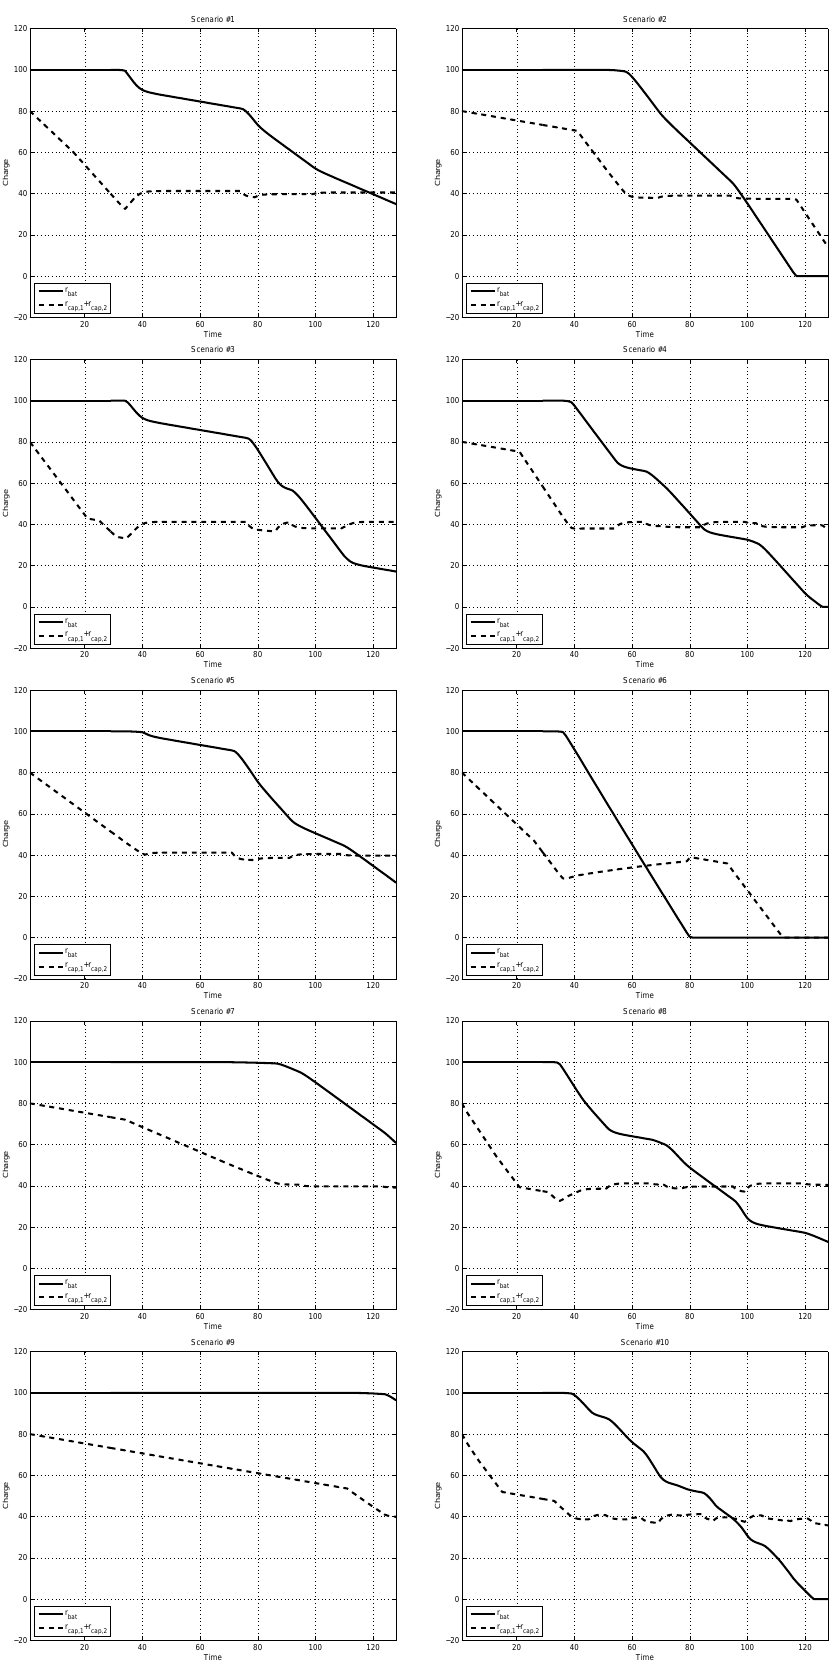
Figure 3. Charge-depleting patterns of the battery and supercapacitors resulting from the ADP-based approach of this